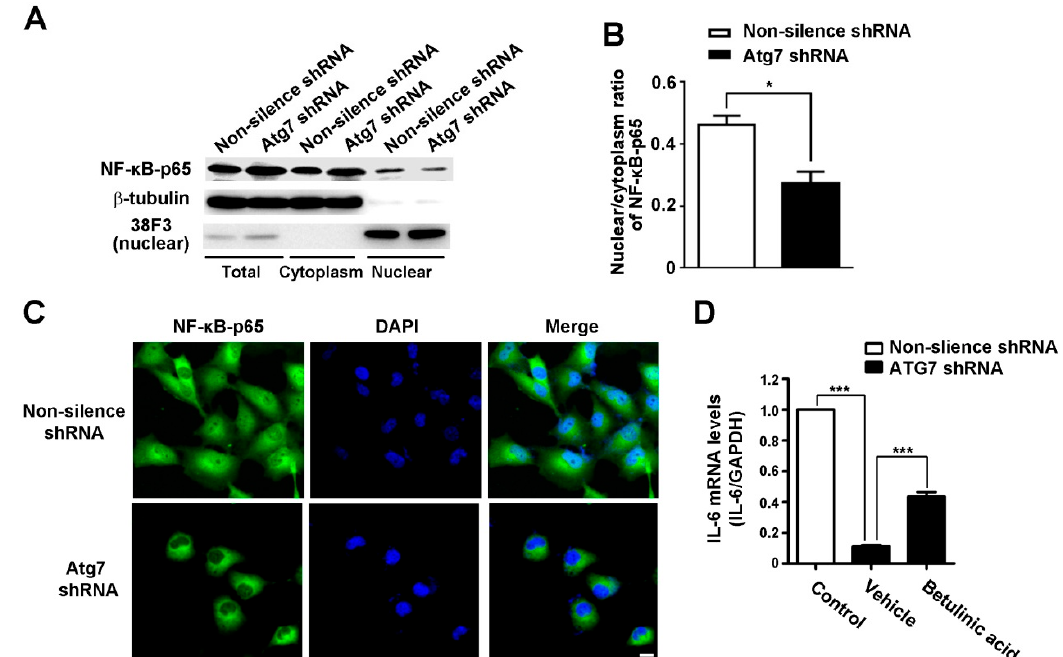
Figure 6. Interleukin-6 promoted cell migration to rescue angiogenesis in the Atg7-knockdown brain microvascular endothelial cells. ( A ) The nuclear and cytoplasmic extracts were obtained in HBMEC stably transfected with Atg7 shRNA1 (Atg7 KD). Then the expression of the NF- κ B p65 subunit was analyzed by western blot. β -tubulin and 38F3 were detected as marker proteins for cytoplasm and nuclear, respectively. HBMEC transfected with non-silencing shRNA were used as control. The representative images were from three independent experiments; ( B ) To quantify the results in ( A ), the band intensities of p65 in nuclear and cytoplasm fractions were measured by ImageJ software and the nuclear to cytoplasm ratios of p65 was calculated. * p < 0.05; ( C ) HBMEC stably transfected with Atg7 shRNA1 were seeded on coverslips and immunofluorescence was conducted with antibody against p65 (green). DAPI (blue) was used for counterstaining. HBMEC transfected with non-silencing shRNA were served as a control. Scale, 20 µ m; ( D ) The mRNA levels of IL-6 in the HBMEC transfected with Atg7 shRNA1 were determined by real time RT-PCR, with HBMEC transfected with non-silencing shRNA as a control. When indicated, the cells were incubated with NF- κ B agonist and betulinic acid (10 µ g/mL) for 2 h. *** p < 0.001.